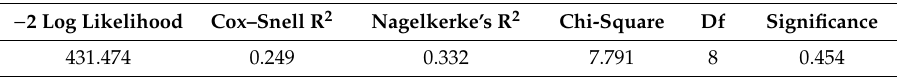
Table 4. Goodness-of-fit results of the consumers’ regression model.